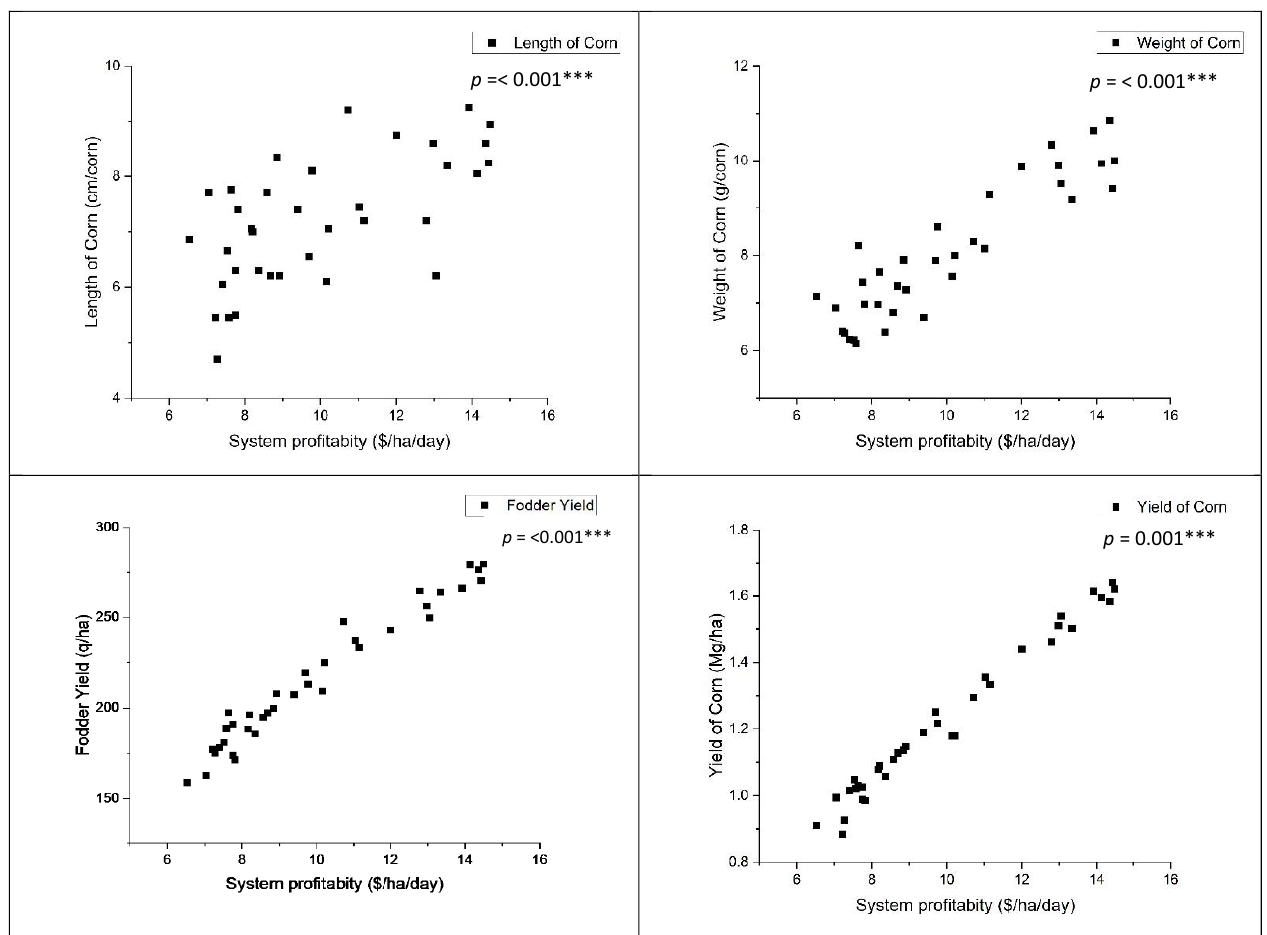
Figure 3. Relationship between system profitability and yield attributes and yield of baby corn. Note: *** represent significant difference at the <0.001 levels.